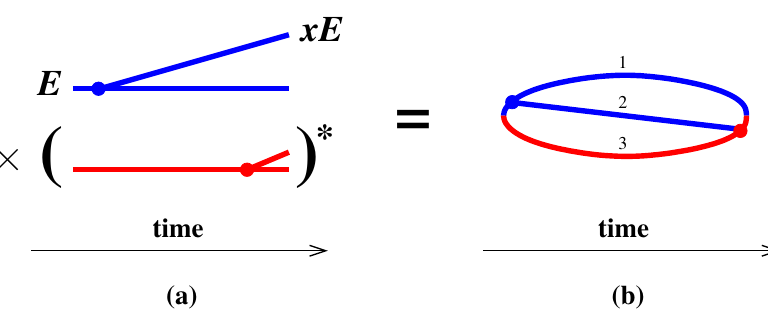
Figure 1 . (a) A time-ordered contribution to the rate for single splitting, such as g → gg , with amplitude in blue and conjugate amplitude in red. (b) A single diagram representing this contri- bution to the rate. In both cases, all lines implicitly interact with the medium. We need not follow particles after the emission has occurred in both the amplitude and conjugate amplitude because we will consider only p ⊥ -integrated rates. (See, for example, section 4.1 of ref. [16] for a more explicit argument, although applied there to a more complicated diagram.) Nor need we follow them before orderings that contribute to the rate is shown above.